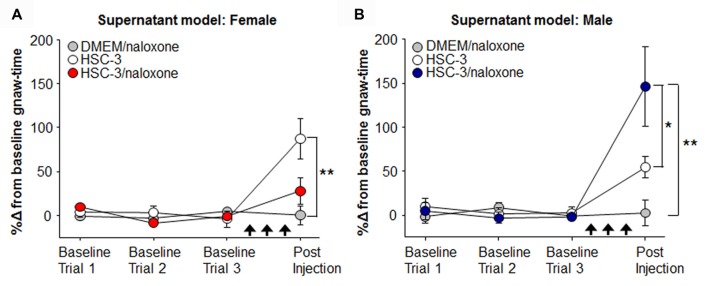
Naloxone potentiation of oral cancer-evoked orofacial pain in male mice. Using the acute oral cancer pain model, female (A) and male (B) mice received three consecutive injections (black arrows) of either opioid receptor antagonist, naloxone (500 μg/kg) in culture media (DMEM/naloxone, gray circle, N = 5 female, 5 male), HSC-3 cell culture supernatant (HSC-3, white circle, N = 5 female, 5 male), or HSC-3 cell culture supernatant with naloxone (HSC-3/naloxone, red circles, N = 8 (A), blue circles, N = 10 (B)) followed by assessment in the dolognawmeter (Post Injection Trial). Data were analyzed as a percent change from the baseline gnaw-time, i.e., the mean of the last three dolognawmeter training trials for each animal. P < 0.05 for Sex vs. Treatment by Two-way ANOVA, *P < 0.05, **P < 0.01 by Holm-Sidak post hoc comparisons.